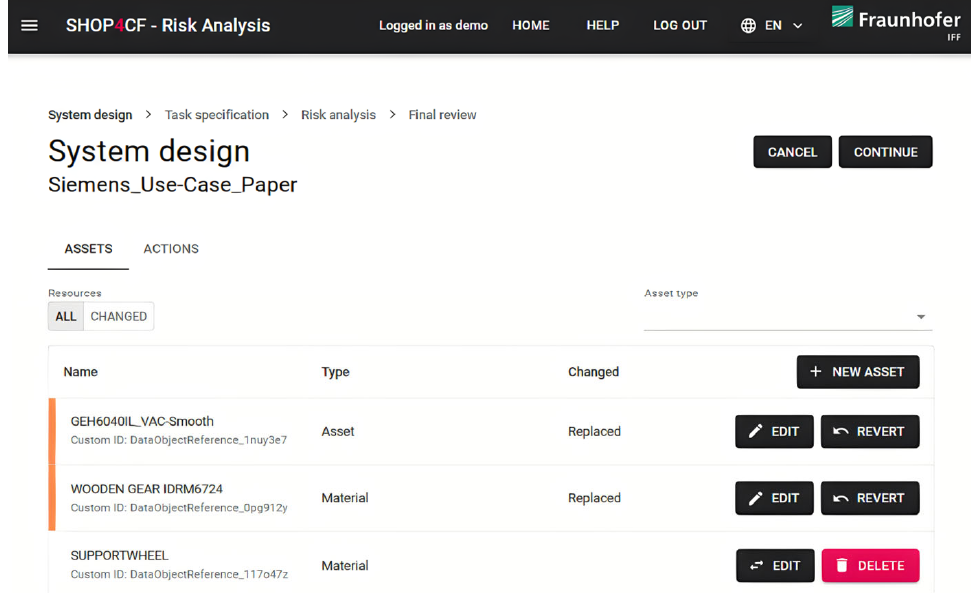
Figure 9. Changing resources in the risk analysis component. After editing the resources, the name of the replaced resource is highlighted in orange to simplify further assessment. The user can also filter according to “changed” with the relevant button.